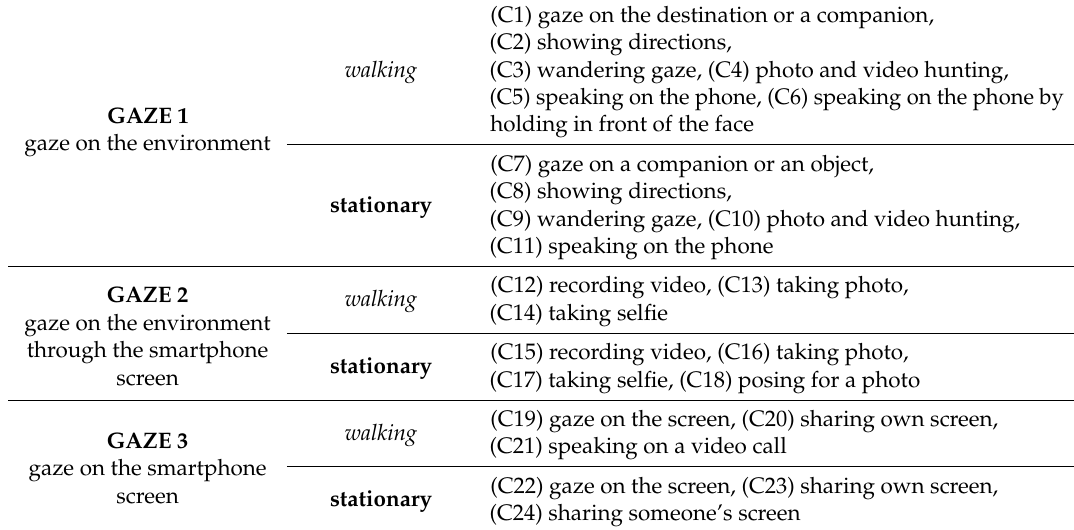
Table 1. Codes for di ff erent gaze types according to